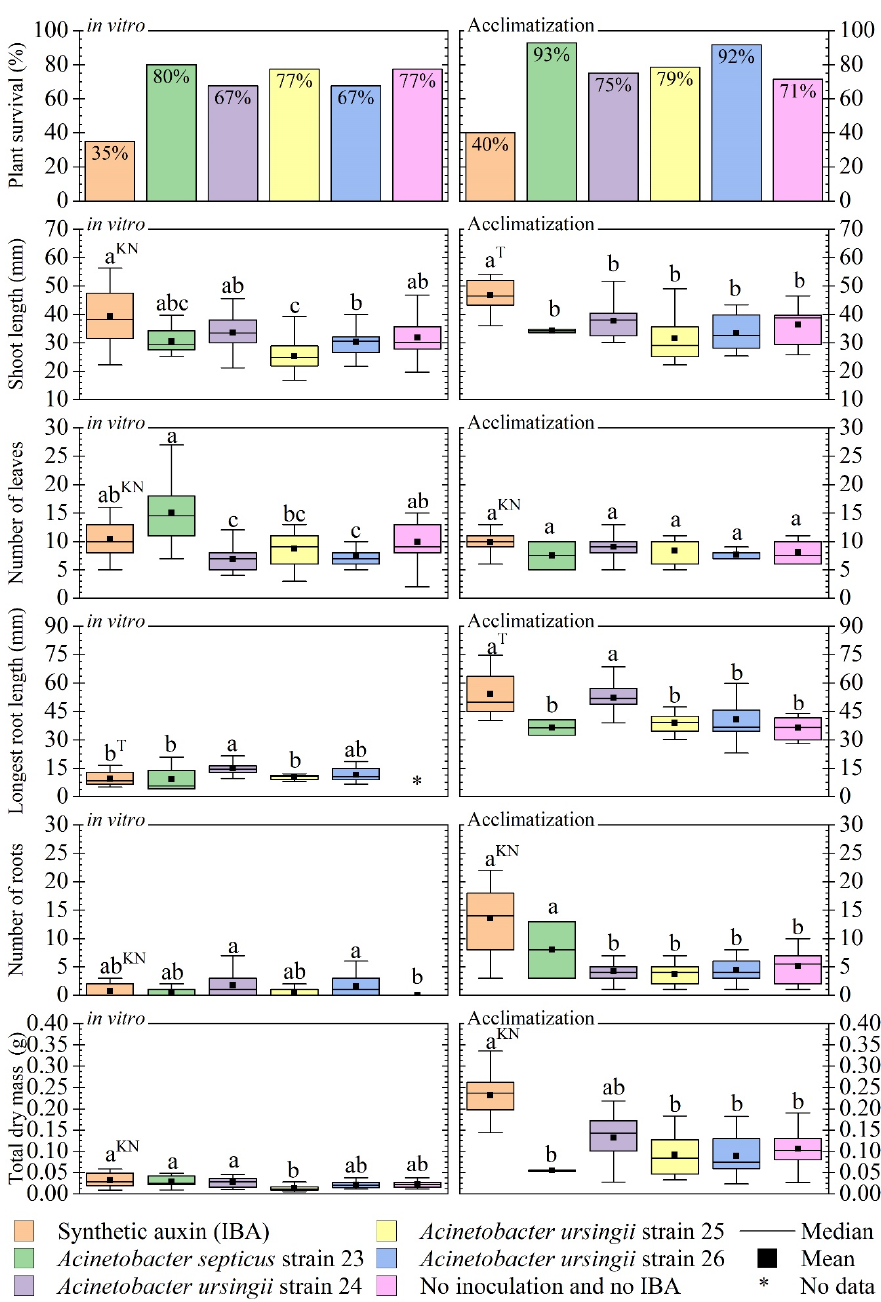
Figure 4. Boxplot and statistical tests for in vitro inoculation and acclimatization of ‘OH×F87 ′ rootstock. Legend: Statistics: T—means followed by the same letter do not differ by the Tukey test at the 5% confidence level; KN—means followed by the same letter do not differ by the Kruskal-Wallis- Nemenyi test at the 5% confidence level. Lowercase letters indicate significant